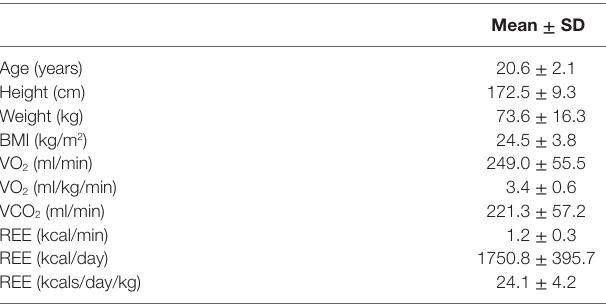
tABLe 1 | Participant